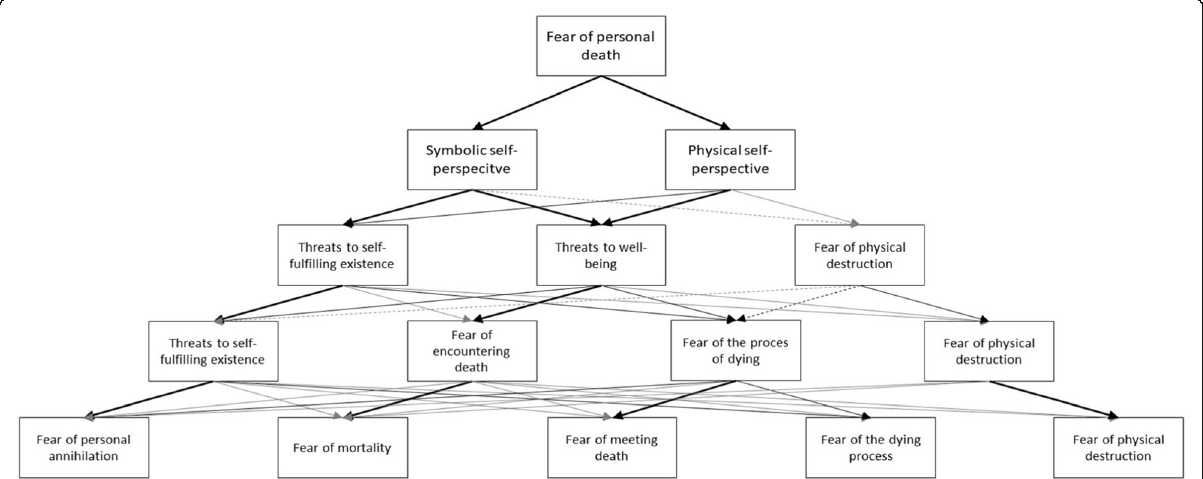
Fig. 1 Hierarchical structure of the fear of personal death. Arrows represent significant correlations between factors higher than 0.40. The strongest correlations have been bolded. Note. Thick black arrow: correlation > 0.70; black arrow: correlation > 0.50; grey arrow: correlation > 0.30; dotted line: negative